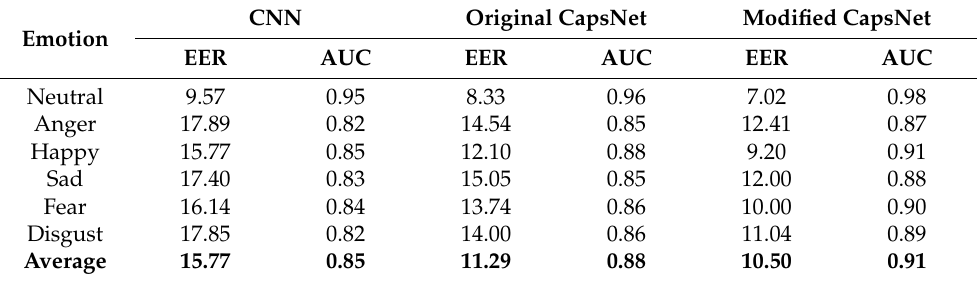
Table 2. Speaker verification performance in terms of EER and CNN of each of CNN, original CapsNet, and modified CapsNet using the Emirati dataset.